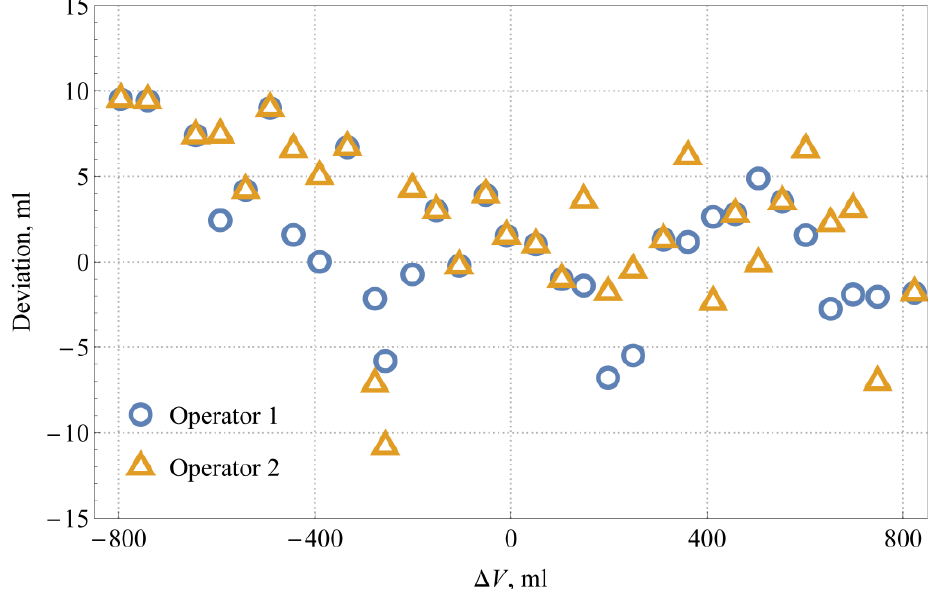
Figure 11. Deviations between the readings of the machine vision system and the operators for different liquid levels.